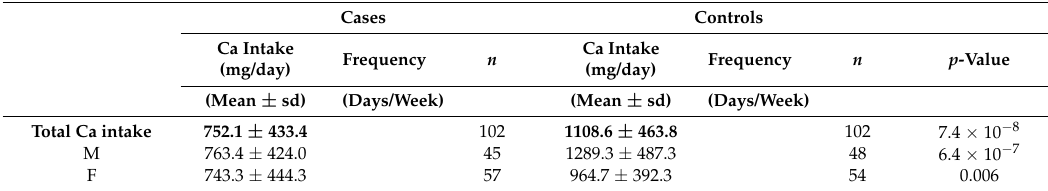
Table 2. Comparative analysis of the Ca intake divided into food